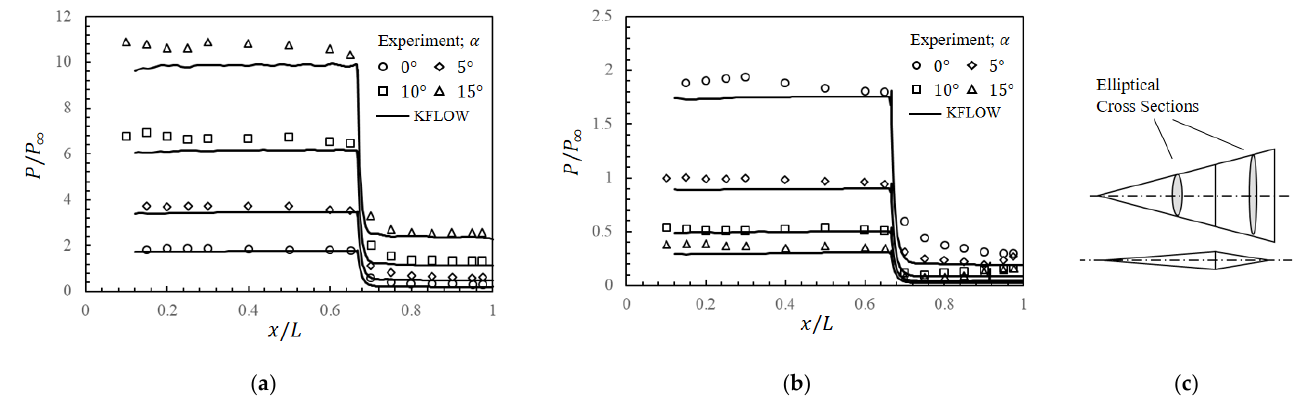
Figure 6. Effect of angle of attack on centerline surface pressures : ( a ) windward cases; ( b ) leeward cases; experimental model ( c ) all-body model [21].